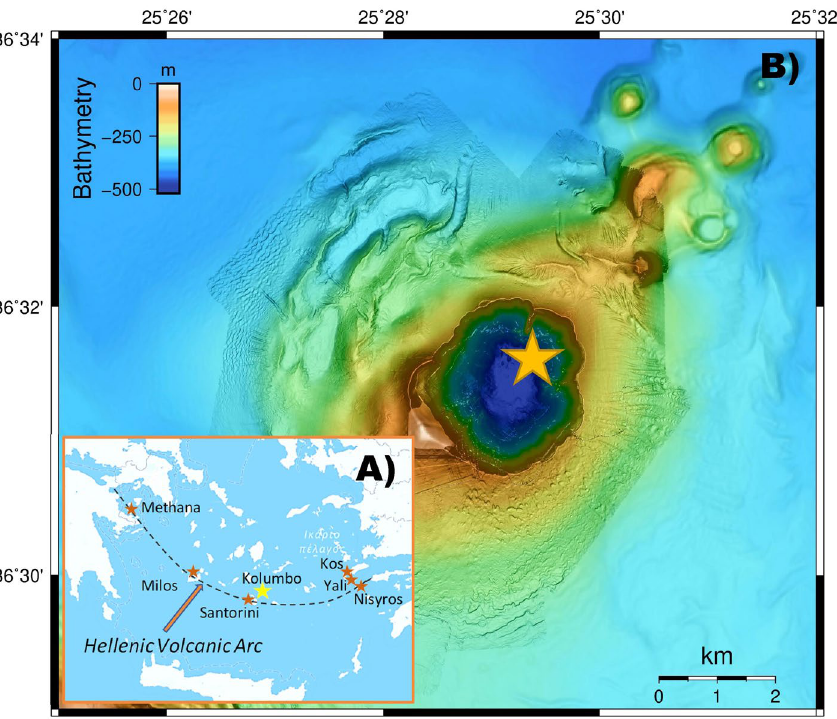
Figure 1. Maps and bottom topography of the sampling location. (A) Map showing the location of the Hellenic Volcanic Arc in the Aegean Sea and the study area of Kolumbo volcano. (B) High resolution Autonomous Underwater Vehicle (AUV)-collected bathymetry at 2 m resolution of Kolumbo crater showing the location of the surface and deep seawater samples that were used for Pseudomonas strains isolation. AUV data were collected during POS510 cruise, in 7 missions of AUV Abyss (GEOMAR), under the framework of the collaborative project “ANYDROS: Rifting and Hydrothermal Activity in the Cyclades Back-arc Basin” (modified from Nomikou et al. 70 ). For the swath data processing, visualization, and bathymetric maps we used the